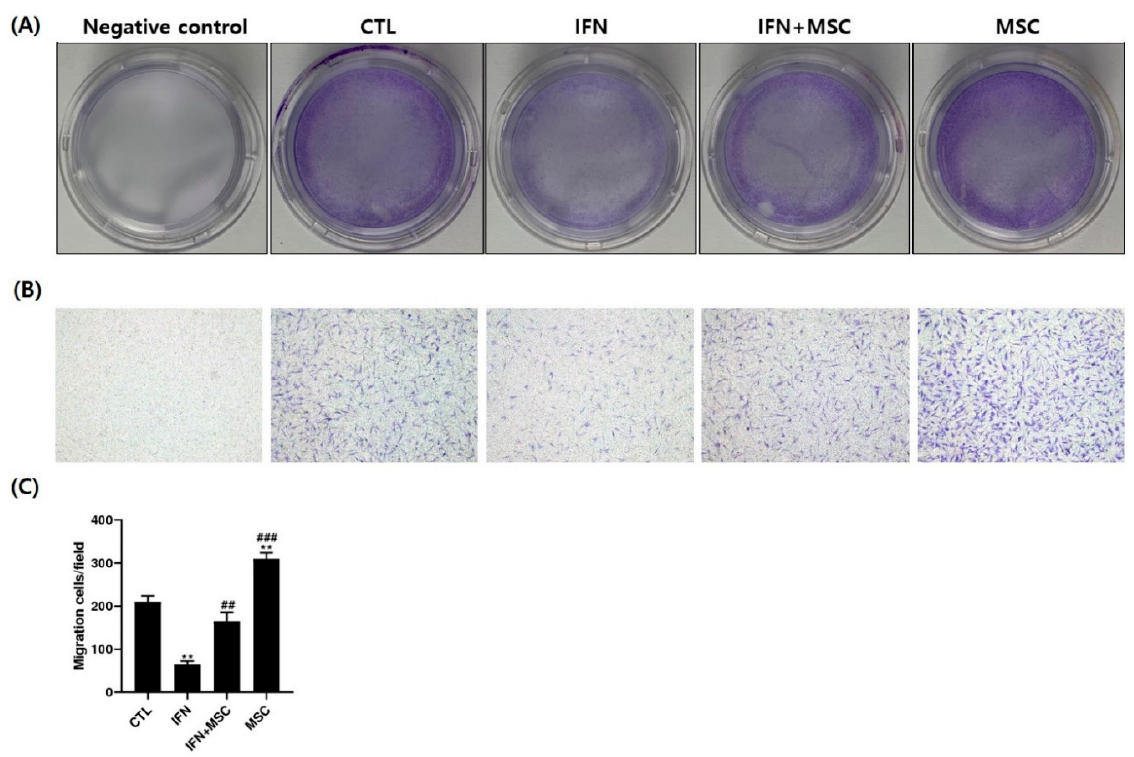
Figure 8. Transwell migration assay. The effect of hHMSC co-culture on hORSC migration was examined using the crystal violet assay. ( A ) Macroscopic observation of the Transwell chamber containing the negative control. ( B ) Images of migrated cells stained by crystal violet at ×100 magnification. ( C ) Quantification of the migrated cells. Cell migration ability was decreased in the IFN- γ -treated group but increased in the hHMSC co-culture group compared to the control. Compared to the IFN- γ -treated group, the migration ability of the IFN- γ -hHMSC-treated group and the hHMSC co-culture group was significantly increased. Error bars represent the mean ± SEM, n = 3. Statistically significant at ** p < 0.01 compared to the control and ## p < 0.01 and ### p < 0.001 compared to the IFN- γ -treated group.